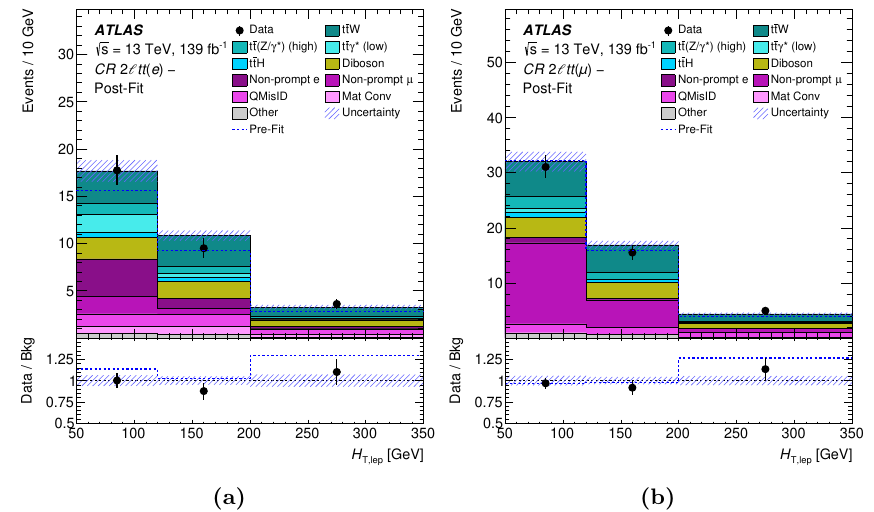
Figure 9. Comparison between data and the background prediction for the distribution of the scalar sum of the lepton p ( H ) in (a) the 2 ‘ tt(e)- CR and (b) the 2 ‘ tt( µ )- CR. The background T T, lep contributions after the likelihood fit to data (“Post-Fit”) under the background-only hypothesis are shown as filled histograms. The total background prediction before the likelihood fit to data (“Pre-Fit”) is shown as a dashed blue histogram in the upper panel. The ratio of the data to the background (“Bkg”) prediction is shown in the lower panel, separately for post-fit background (black points) and pre-fit background (dashed blue line). The size of the combined statistical and systematic uncertainty in the background prediction is indicated by the blue hatched band. The last bin in each figure contains the overflow.